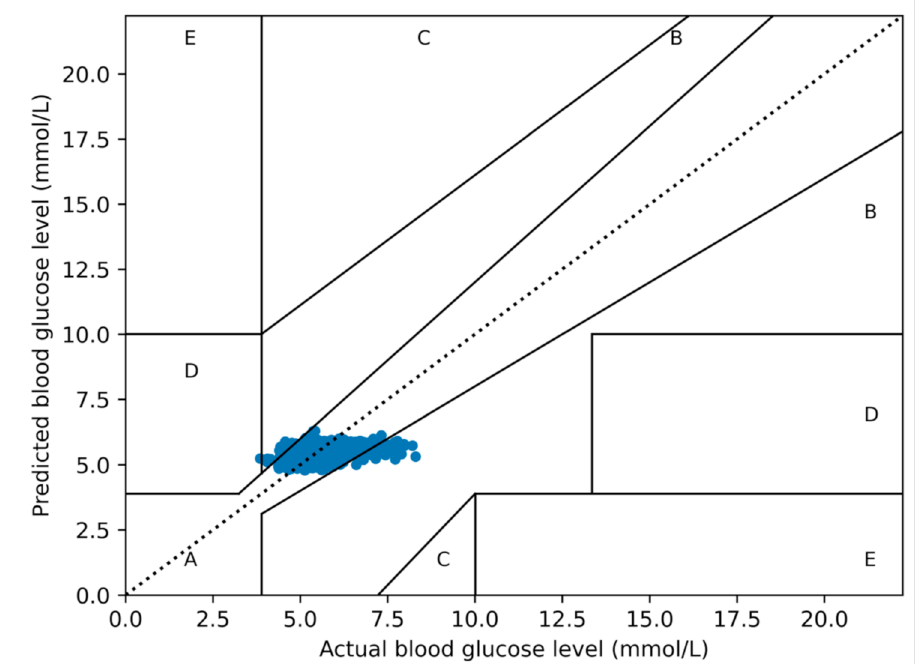
Figure 14. The EGA diagram for the RG_XGBoost model.